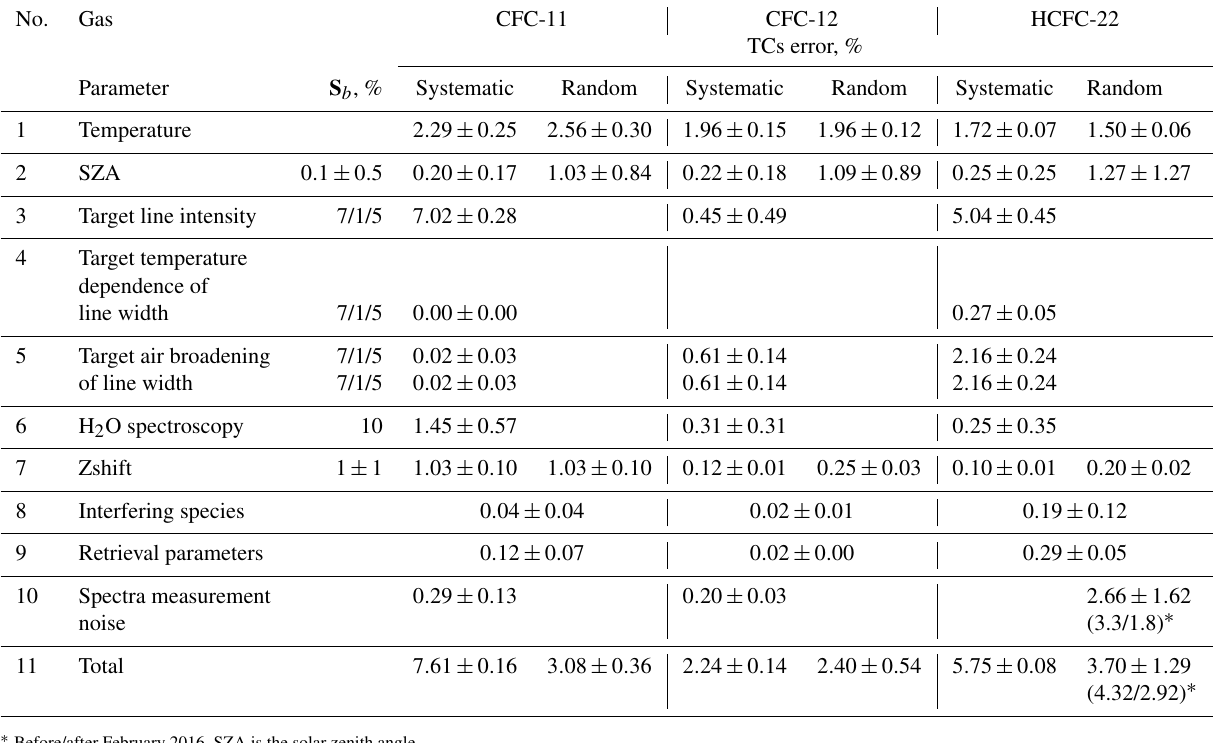
Table 4. Error budget for retrieved halocarbons TCs. The relative uncertainties of spectroscopic parameters are 7%, 1%, and 5% for CFC-11, CFC-12, and HCFC-22, respectively. S b means the a priori imprecision of parameters.